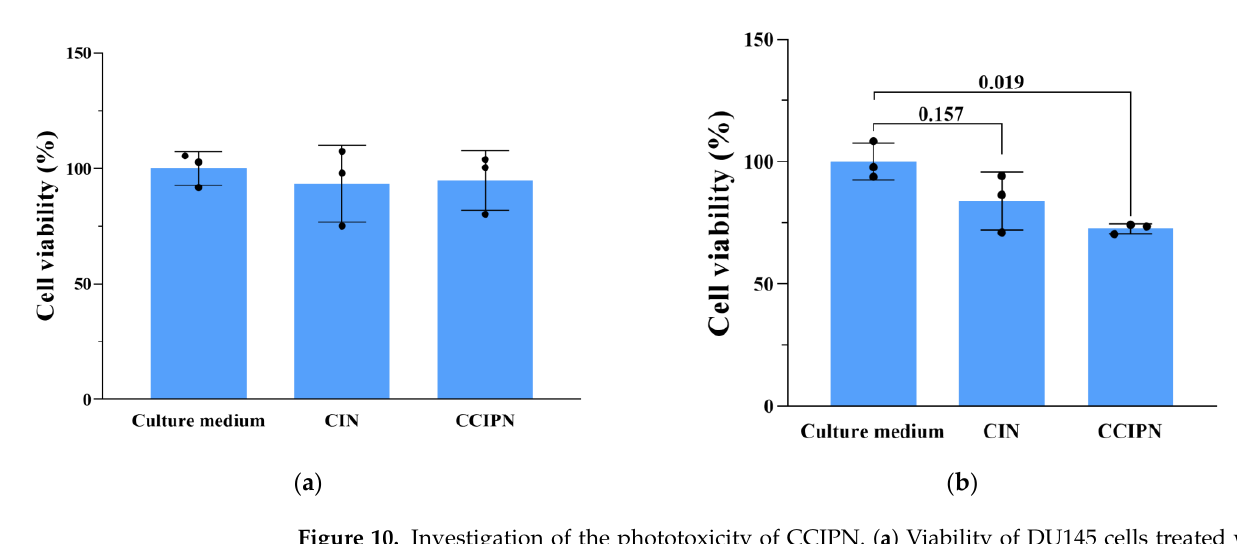
Figure 10. Investigation of the phototoxicity of CCIPN. ( a ) Viability of DU145 cells treated with culture medium, CCIPN at 0.075 µg mL − 1 , or CIN at 0.075 µg mL − 1 under no irradiation. ( b ) Viability of DU145 cells treated with culture medium, CCIPN at 0.075 µg mL − 1 , or CIN at 0.075 µg mL − 1 under irradiation. Values are expressed as mean ± SD (n = 3). Each dot represents an independent experiment. The p value vs. indicated group is presented.